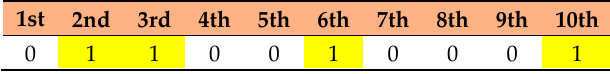
Figure 2. An example of a solution with 10 dimensions.